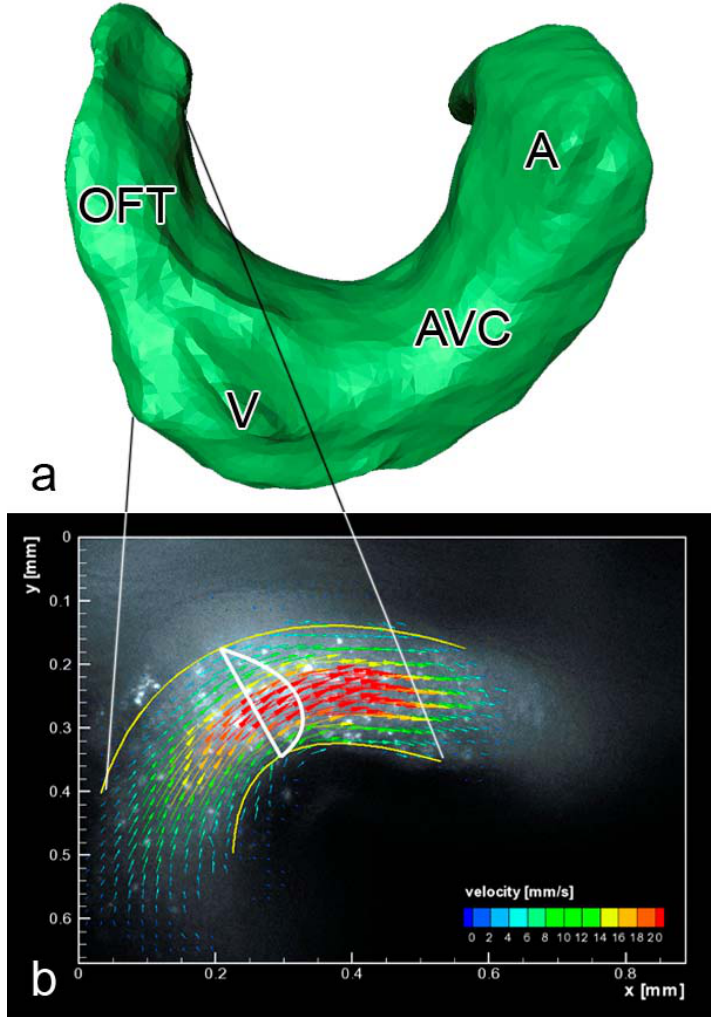
FIGURE 2. Geometry and measured velocity profile of the heart at HH16. The endocardium of the HH16 chicken embryonic heart was fluorescently labeled and analyzed by CLSM. (a) The natural geometry of the lumen in full dilatation was deduced by subsequent 3D reconstruction. (b) Systolic blood flow in the outflow tract (OFT) area of a living HH16 chicken embryo was quantified by µPIV analysis. Note that the measured velocity profile is asymmetric with a shift of maximum velocity to the inner curvature of the heart. A = atrium, AVC = atrioventricular canal, V = ventricle. Fig. b is adapted from Vennemann et